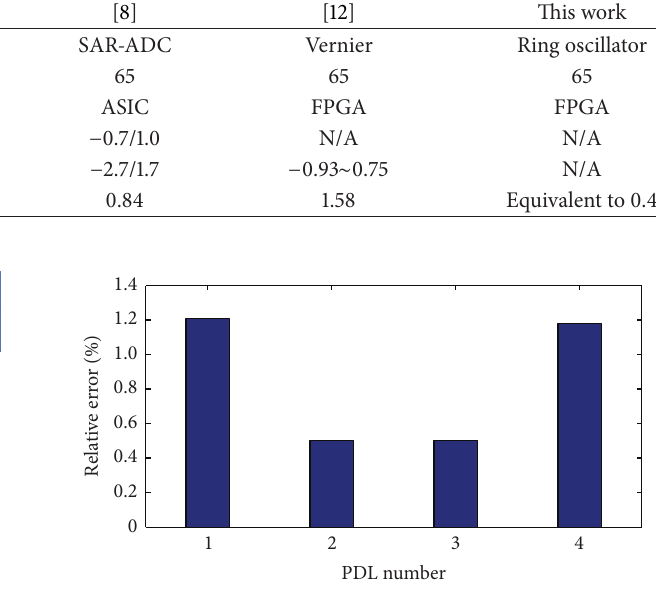
Figure 7: Relative error variation for four